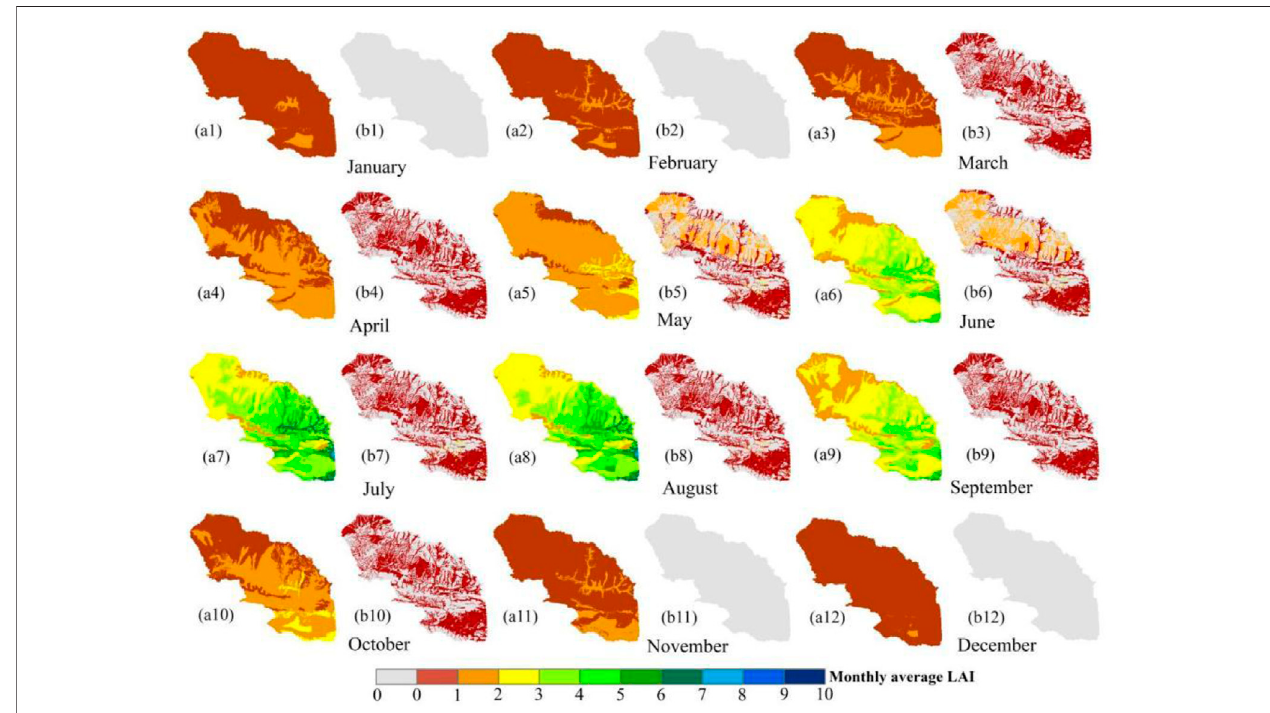
FIGURE 7 | The remotely sensed (a1 – a12) and Soil and Water Assessment Tool (SWAT)-simulated (b1 – b12) long term (2014 – 2018) monthly average leaf area index (LAI) on hydrological response units (HRUs). The boundaries between the HRUs are not shown.